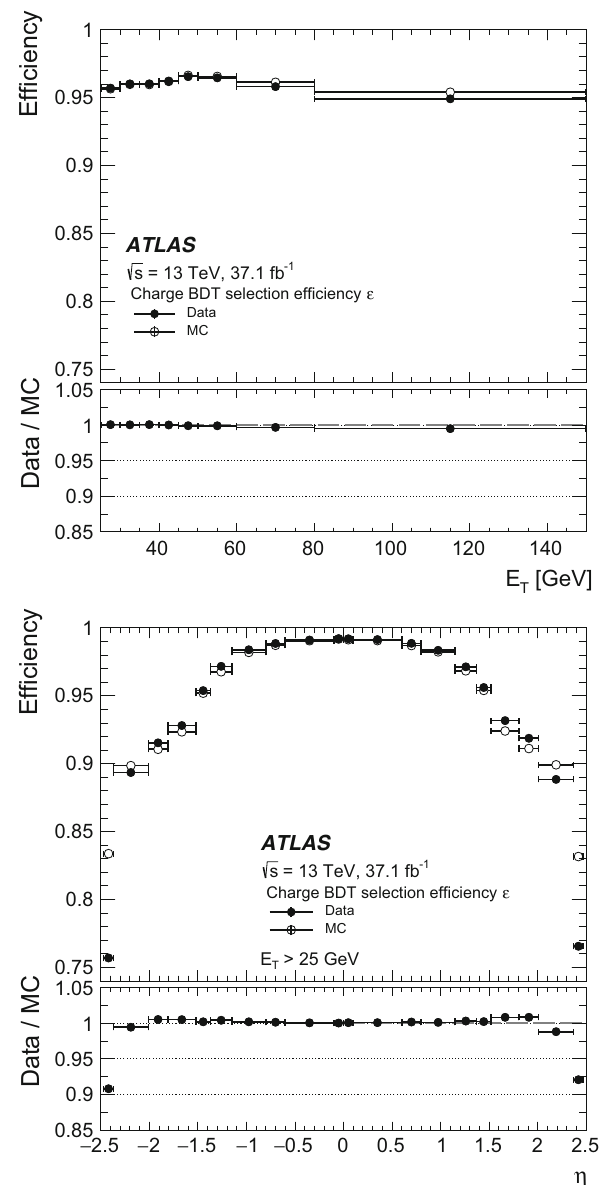
Fig. 14 Efficiency of applying the additional BDT selection criterion to choose Medium-identified electrons reconstructed with the correct charge, as evaluated in Z → ee events. The criterion is based on a BDT discriminant optimised to select electrons with a correct charge assign- mentwithanefficiencyof97%.Top:vs. E T ;bottom:vs. η .Openpoints: data; closed points: simulation; and lower panels: data-to-simulation ratios. The uncertainties are smaller than the markers and hence not visible linearly interpolating to estimate the number of events under the mass